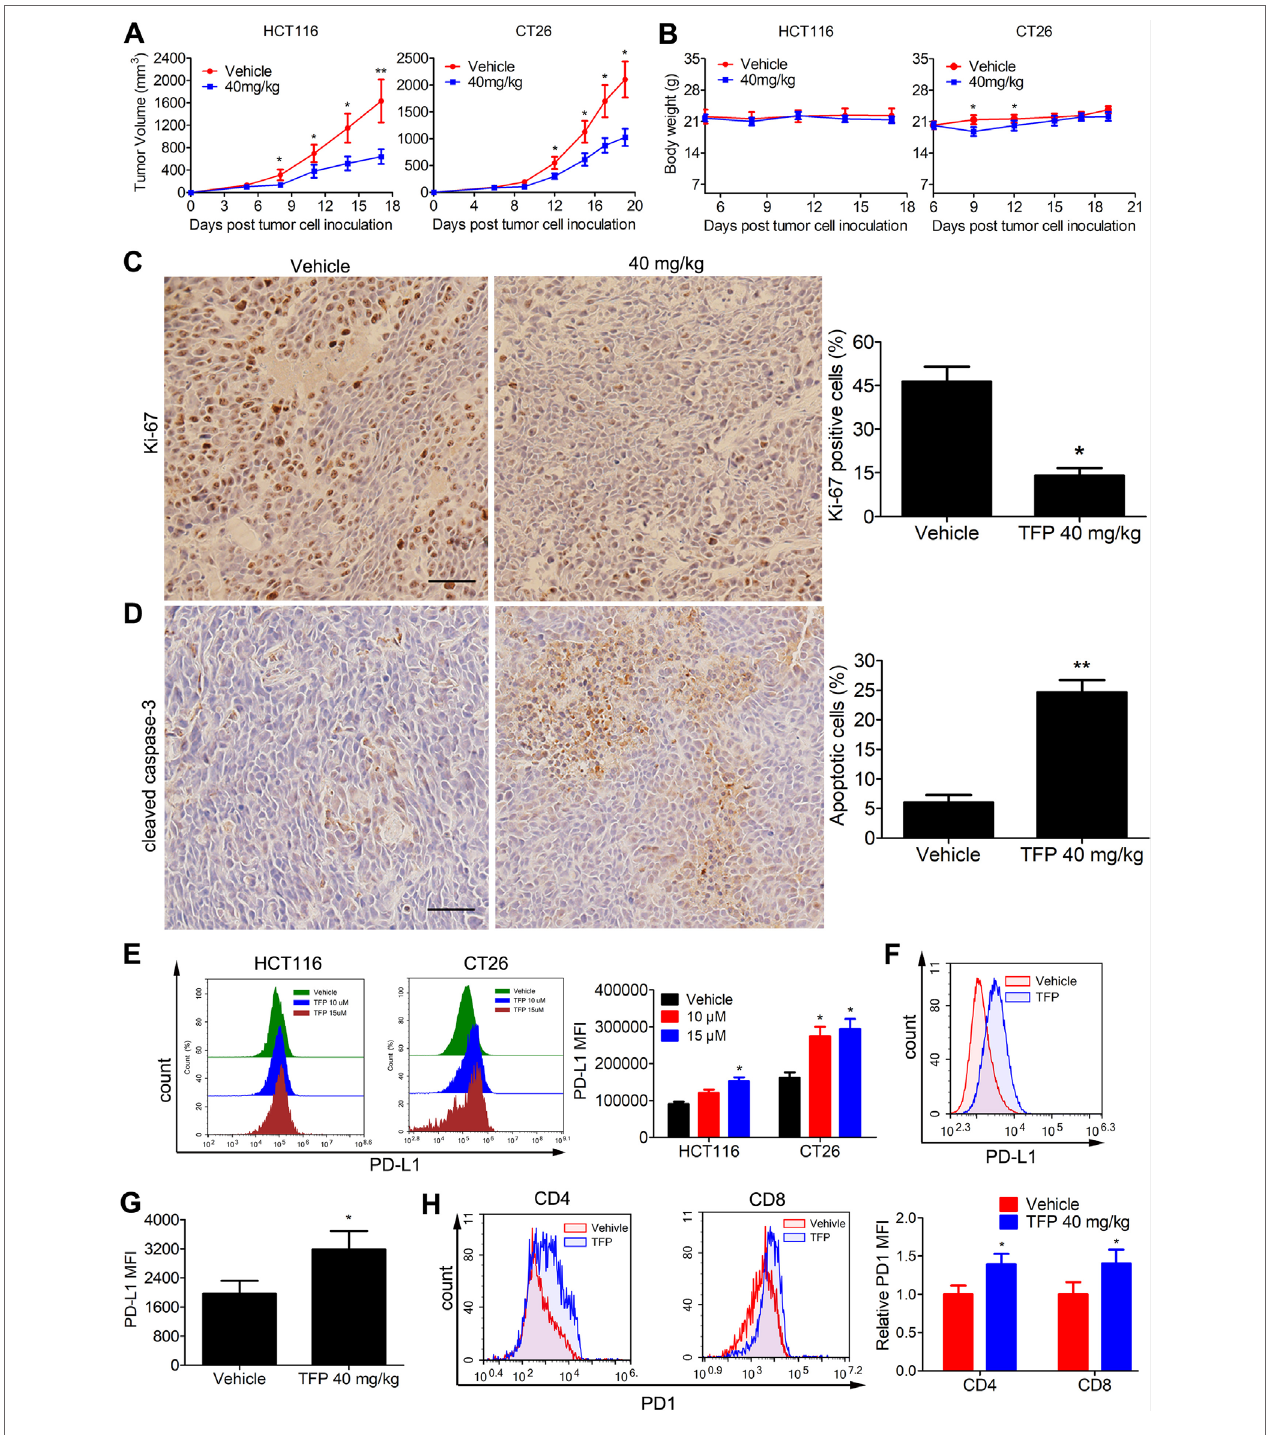
FIGURE 7 | Effects of TFP on the growth of CT26 and HCT116 subcutaneous tumor in vivo . (A) Tumor volume changes in mice during TFP treatment. (B) Body weight changes of the mice during TFP treatment. (C and D) At the end of treatment of human HCT116 xenograft models in BALB/c nude mice, cleaved caspase-3 and Ki-67 expression levels in the tumor tissues were detected by Immunohistochemistry analysis. Quantification of the IHC analysis is shown to the right. (E) TFP treatment induced the expression of PD-L1 in vitro in cultural CRC cells. HCT116 and CT26 cells were treated with TFP for 48 h. The cells were stained with antibody against PD-L1 and analyzed by FCM. (F – H) Single cell suspensions were obtained from CT26 subcutaneous tumor tissues in immune-competent BALB/c mice at the end of treatment. The cells were stained with antibodies against mouse CD4, CD8, CD45, PD1, and PD-L1 followed by FCM analysis. (F and G) TFP treatment increased PD-L1 expression in the tumor cells from CT26 tumor tissues. Tumor cells were gated from CD45 − cells when performing the FCM analysis. (H) TFP treatment increased PD1 expression in tumor-infiltrating CD4 + and CD8 + T lymphocytes from CT26 tumor tissues. *P < 0.05, **P <